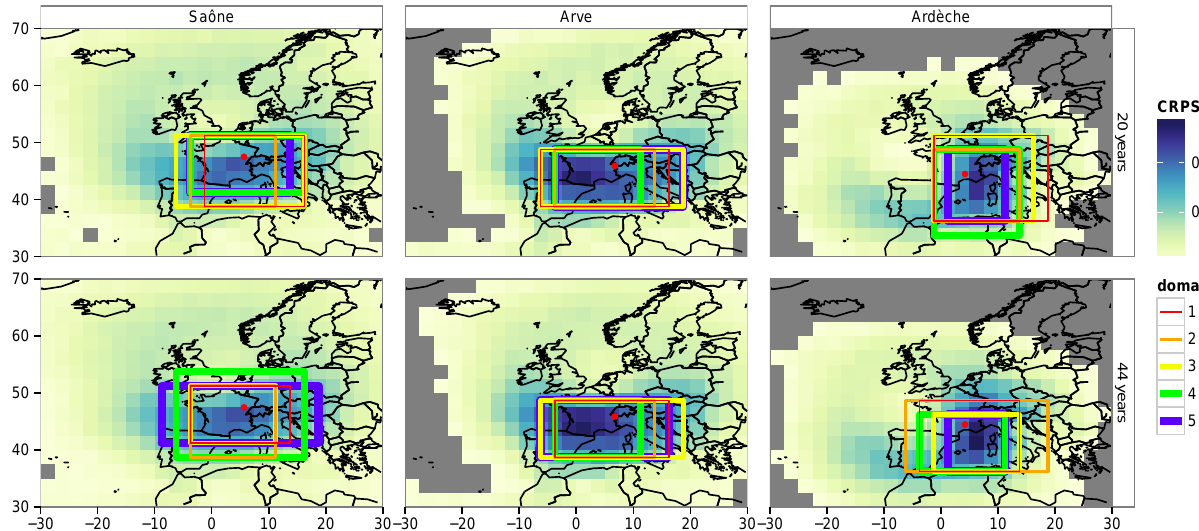
Fig. 10. Optimised predictor domains for three case study zones using 20 years (first row) and 44 years (second row) archive for optimisation. The relevance maps for each zone and each archive length are shown with a colour scale underneath the predictor domains.